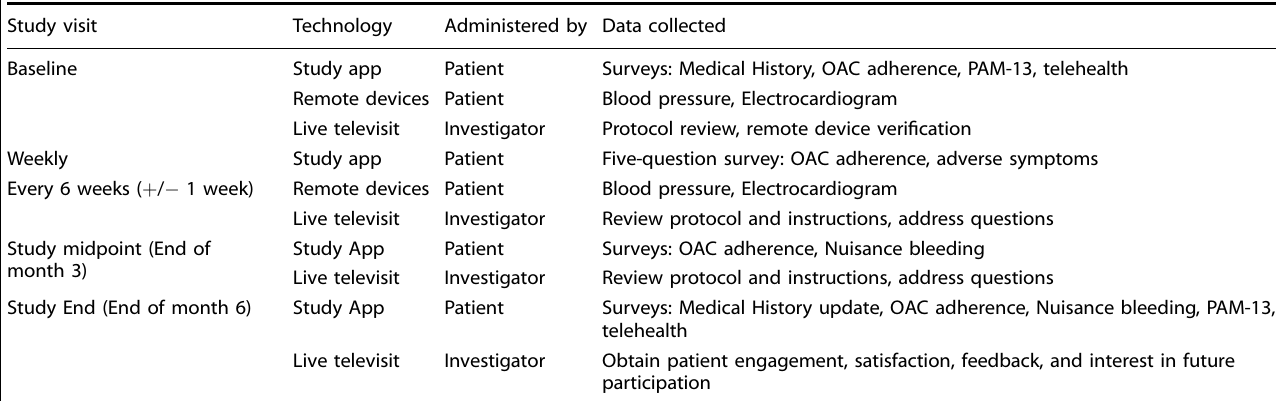
Table 2. Overview of study visits, technologies used, and remote data collection